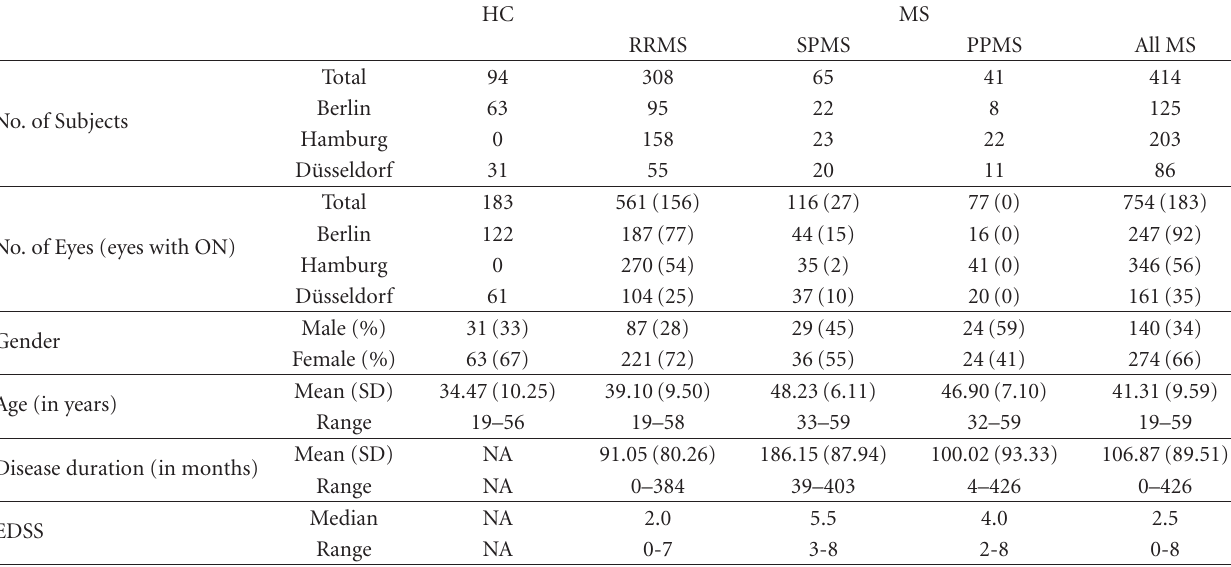
Table 1: Demographic and clinical data of multiple sclerosis patients (MS) and healthy controls (HC). MS patients are subdivided in